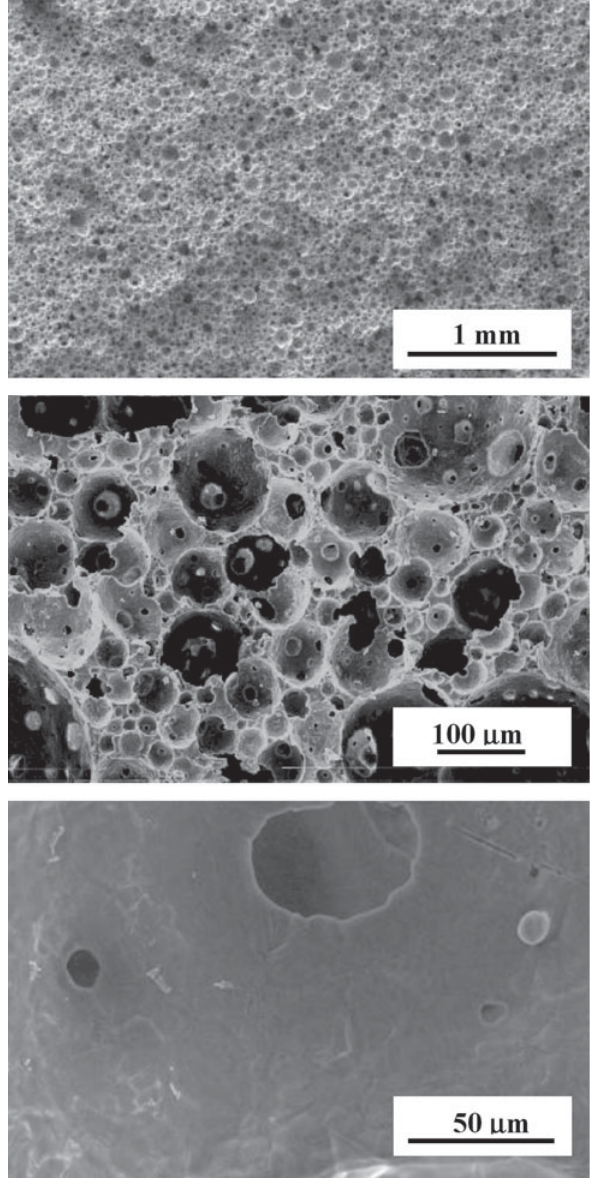
Figure 1. SEM micrographs of hydroxyapatite foams, at various levels of